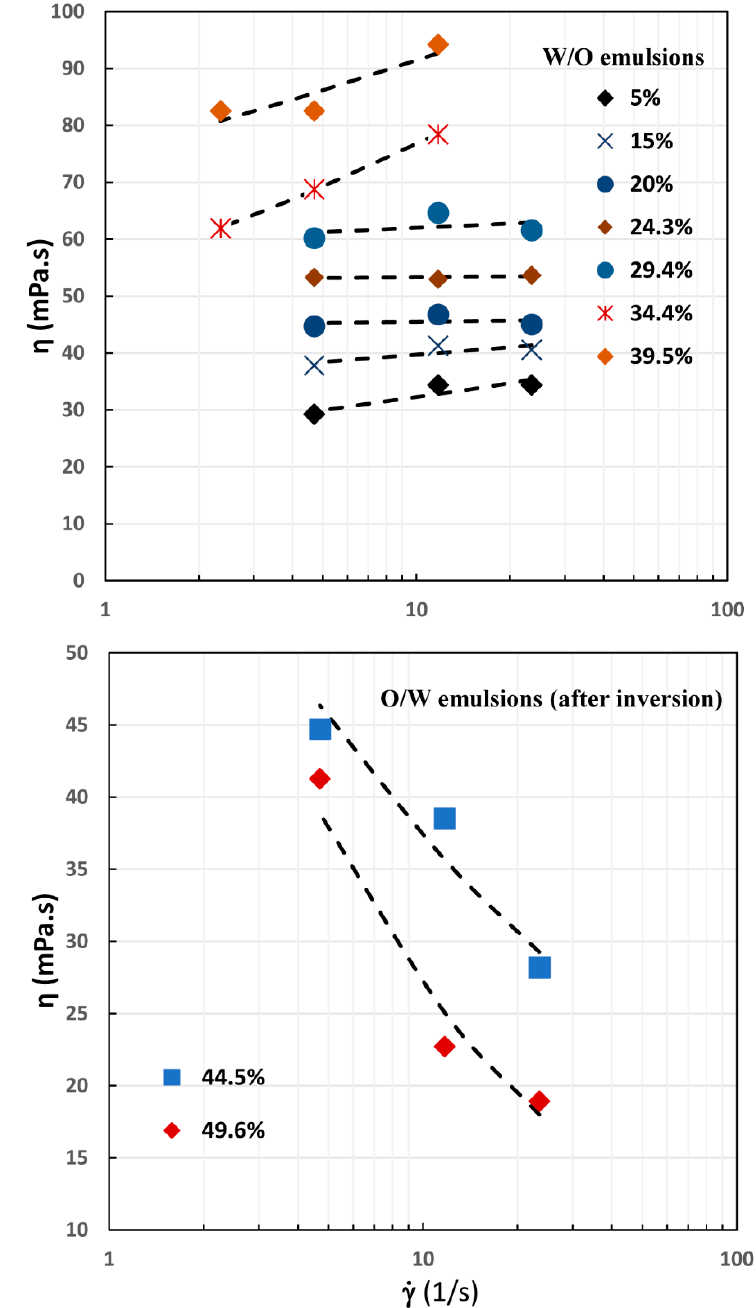
Figure 4. Flow behavior of emulsions with SNP concentration of 0.25% wt. in the aqueous phase. The dashed lines are shown as a guide to the eye. The percent concentrations indicated on the figure are volume percent of aqueous phase.